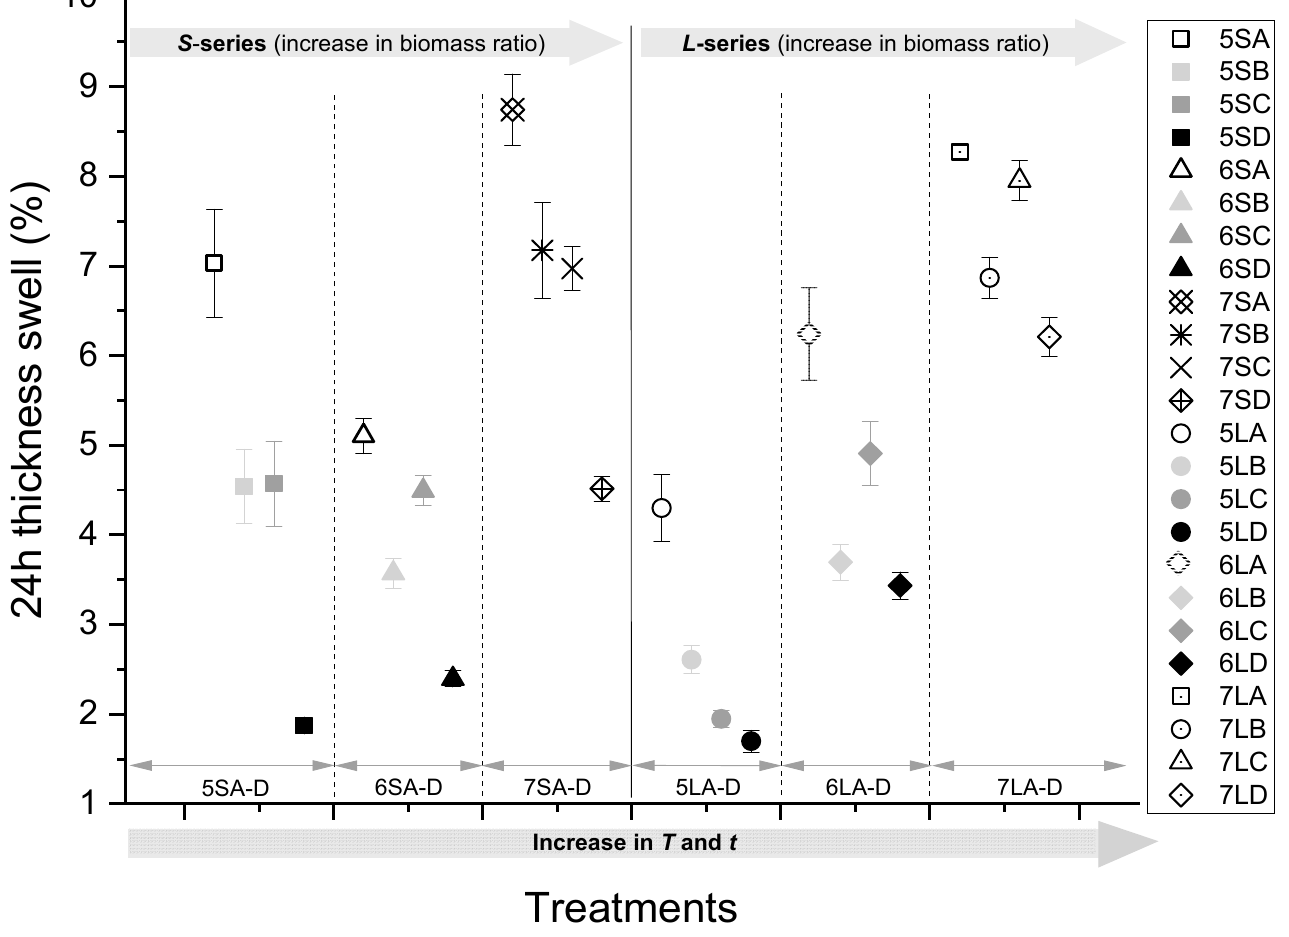
Figure 8. A 24 h TS of WPCs pressed at different temperatures and times (A–D) with 50, 60, and 70% biomass at two particle sizes ( S and L ).